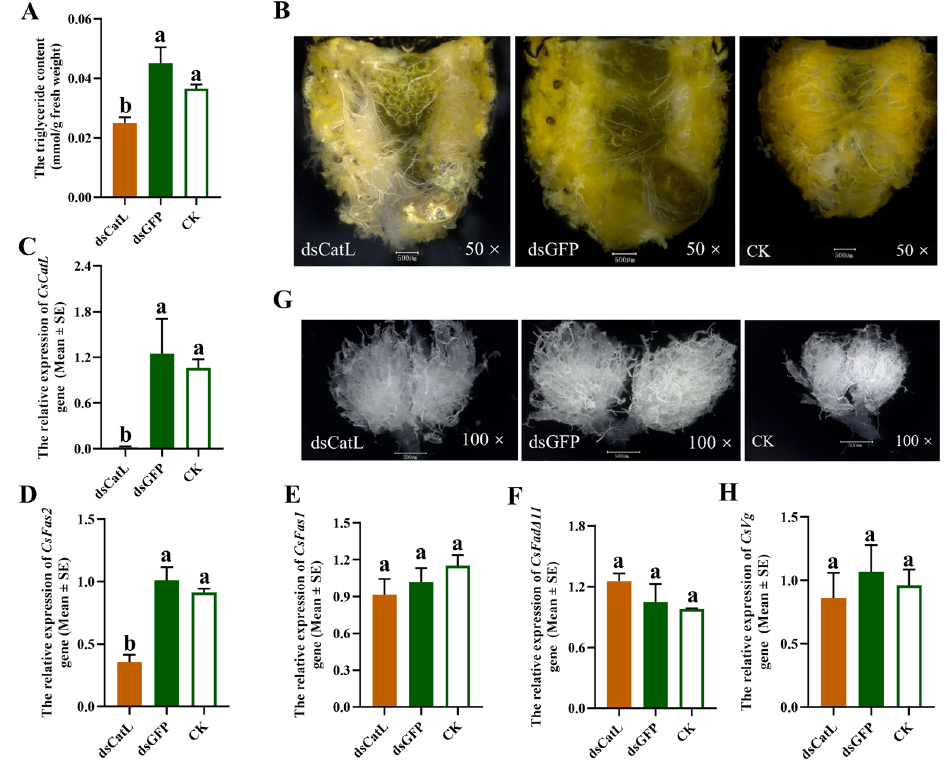
Figure 4. Knockdown of CsCatL in diapause-destined females reduces lipid accumulation. ( A ) The triglyceride content was measured in N9 and D9. Relative expressions of CsCatL ( C ), CsFas1 ( E ) CsFas2 ( D ), CsFad Δ 11 ( F ) and CsVg ( H ), lipid accumulation status ( B ) and ovary development ( G ) were determined on the 7th day after injection with dsRNA. Data are presented as mean ± SE (one-way ANOVA). The letters “a” and “b” respectively indicate significant difference ( p < 0.05) and no significant difference ( p > 0.05).